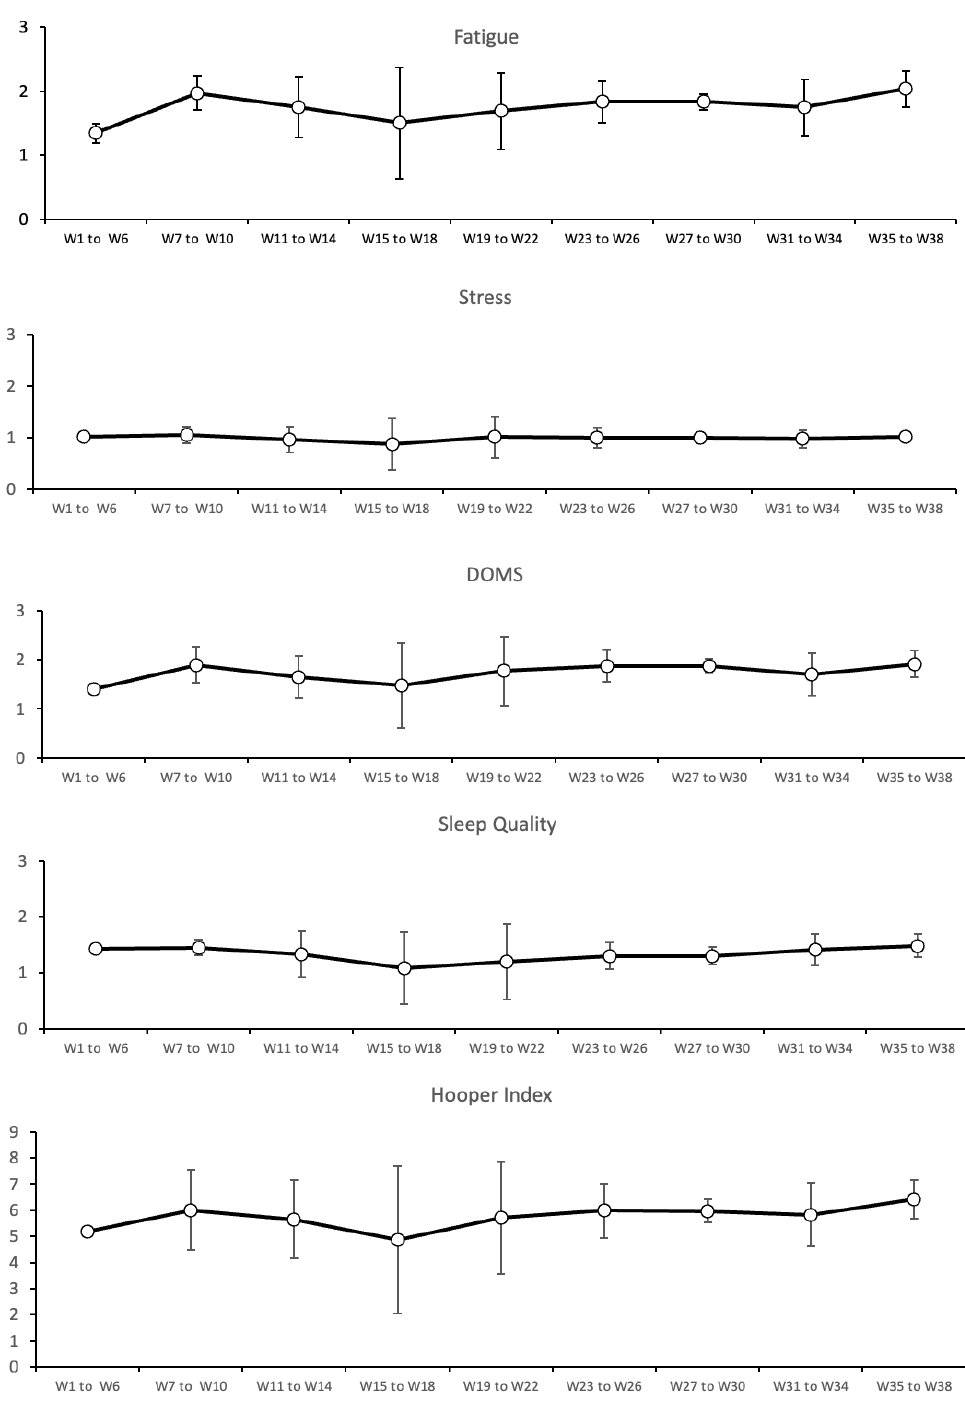
Figure 1. Variations of fatigue, sleep quality, delayed onset muscle soreness (DOMS), stress, and hooper index. W: weeks; A.U.: arbitrary units. Table 3. Well-being variations from preseason, early-season, in season and overall.